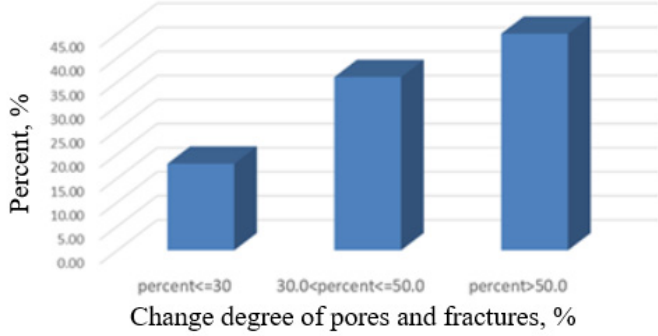
Figure 19. Frequency histogram of change degree of pores and fractures.